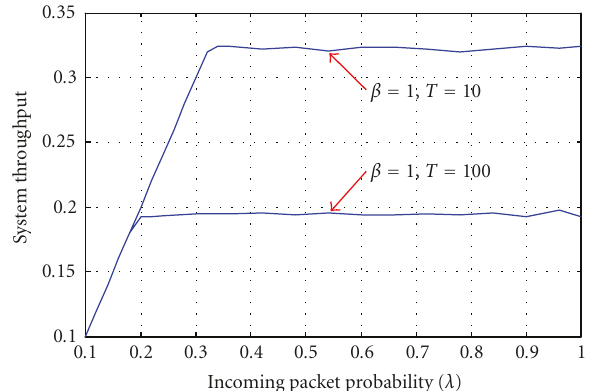
Figure 8: System throughput versus incoming packet probability ( β = 1 .